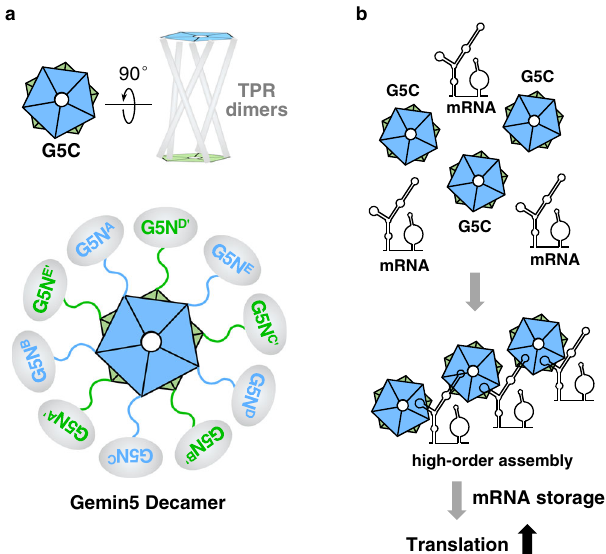
Fig. 7 | Proposed model for the role of G5C in RNA translation. a The G5C decamer is a dimer of pentamers, with fi ve TPR dimers bridging two pentamers. Full-length Gemin5 forms a homodecamer via G5C. b Multivalent interactions betweenG5Candstem-loopregionsofmRNAenablehigh-orderassemblyofRNA ‒ protein complexes. These complexes might upregulate mRNA translation by enabling mRNA storage and preventing mRNA